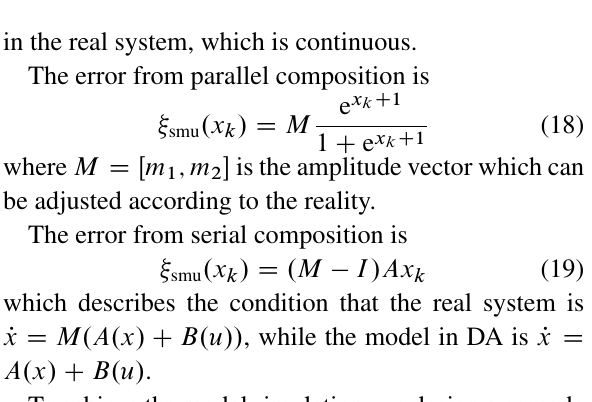
Algorithm 2. The training set is built by the time series F.x DA /; x DA : k 1 k g f (cid:0)